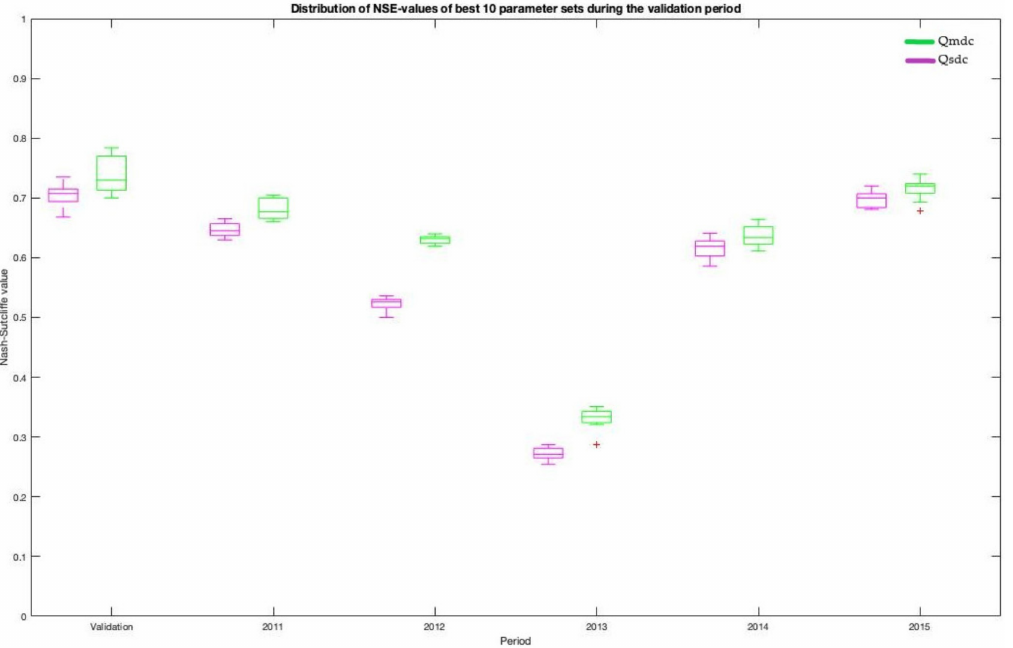
Figure 3. Distribution of Nash–Sutcli ff e e ffi ciency (NSE) values for the 10 best-performing parameter sets (when considering the overall performance criterion) for SDC and MDC simulations during the entire validation period (1 January 2011–26 December 2015) and in each